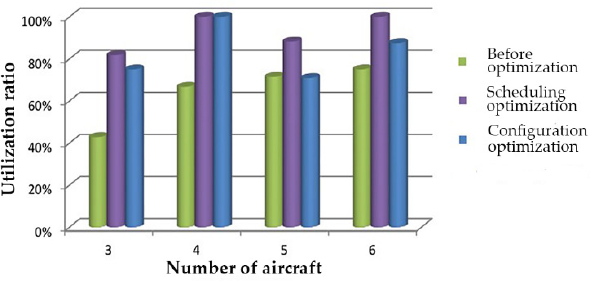
Figure 14. The relationship between the average utilization rate of oxygenation refilling trucks and the number of support aircraft.